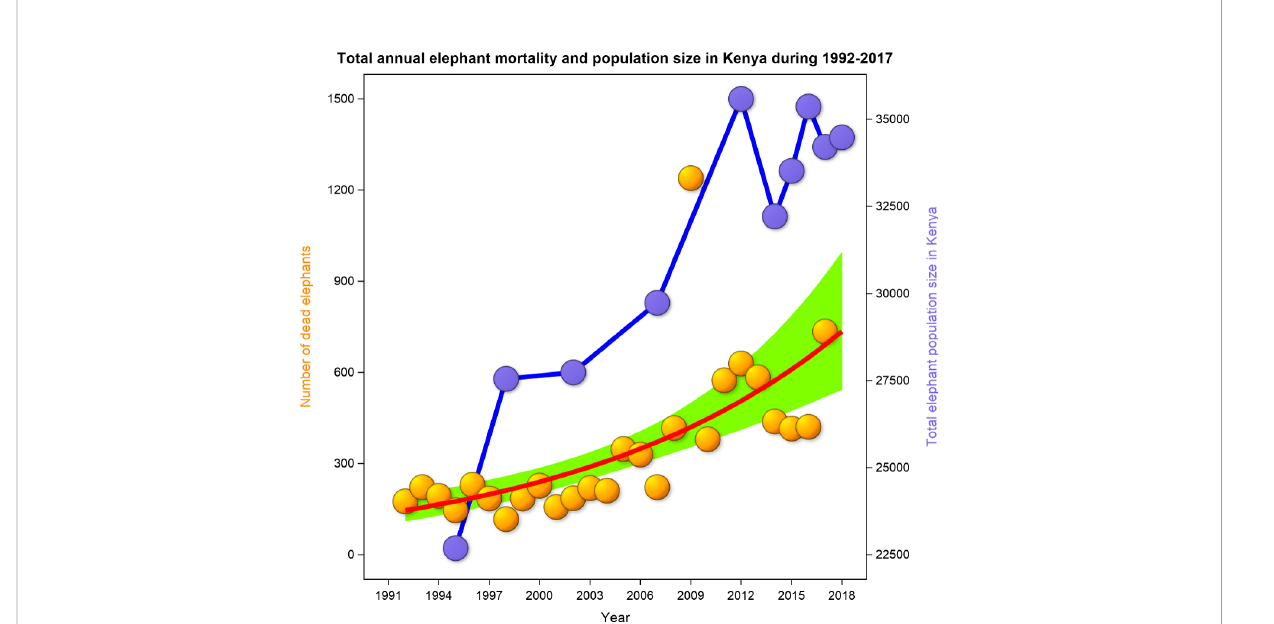
FIGURE 2 The total annual elephant mortality and population size of live elephants in Kenya during 1992-2017.